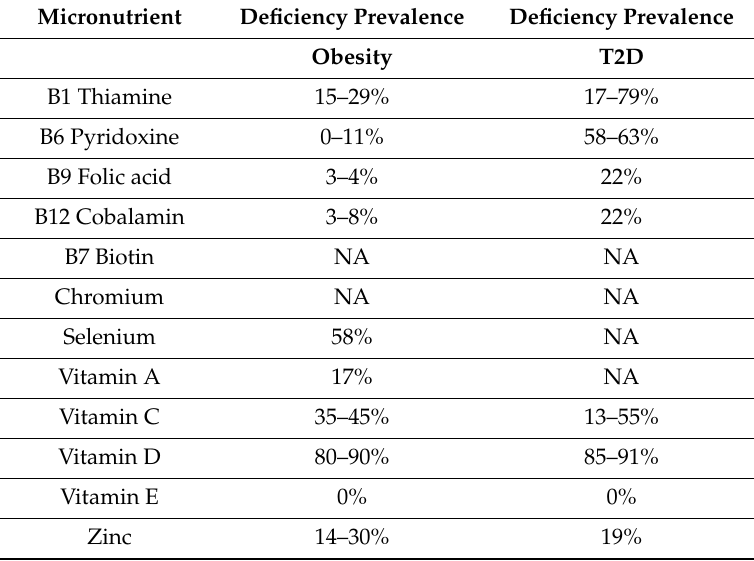
Table 2. Micronutrient Deficiencies A ff ecting